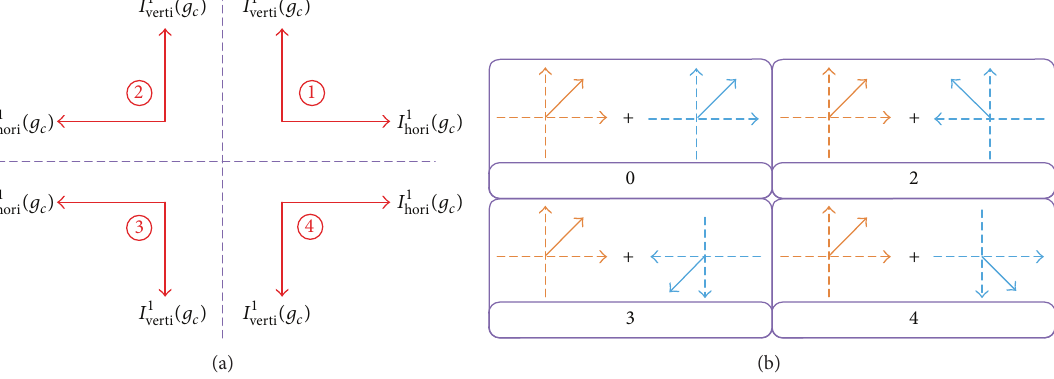
Figure 2: Illustrations tetra pattern based on one of four possible directions of each center pixel. (a) The directions of the center pixel based on (7). (b) Example of calculation of tetra pattern (see (8)-(9)) in the case of the center-pixel direction “1” defined from (7) using the direction of neighbors. Light wheat represents the direction of the center pixel and cyan represents its neighborhood pixels.